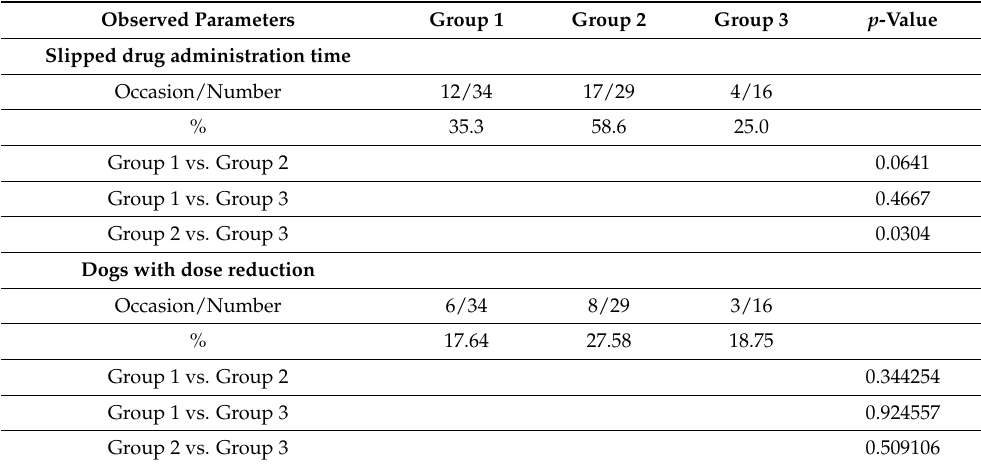
Table 8. A comparison of patient groups with respect to alteration of the treatment regimen due to adverse drug reactions, anorexia, and grade of side